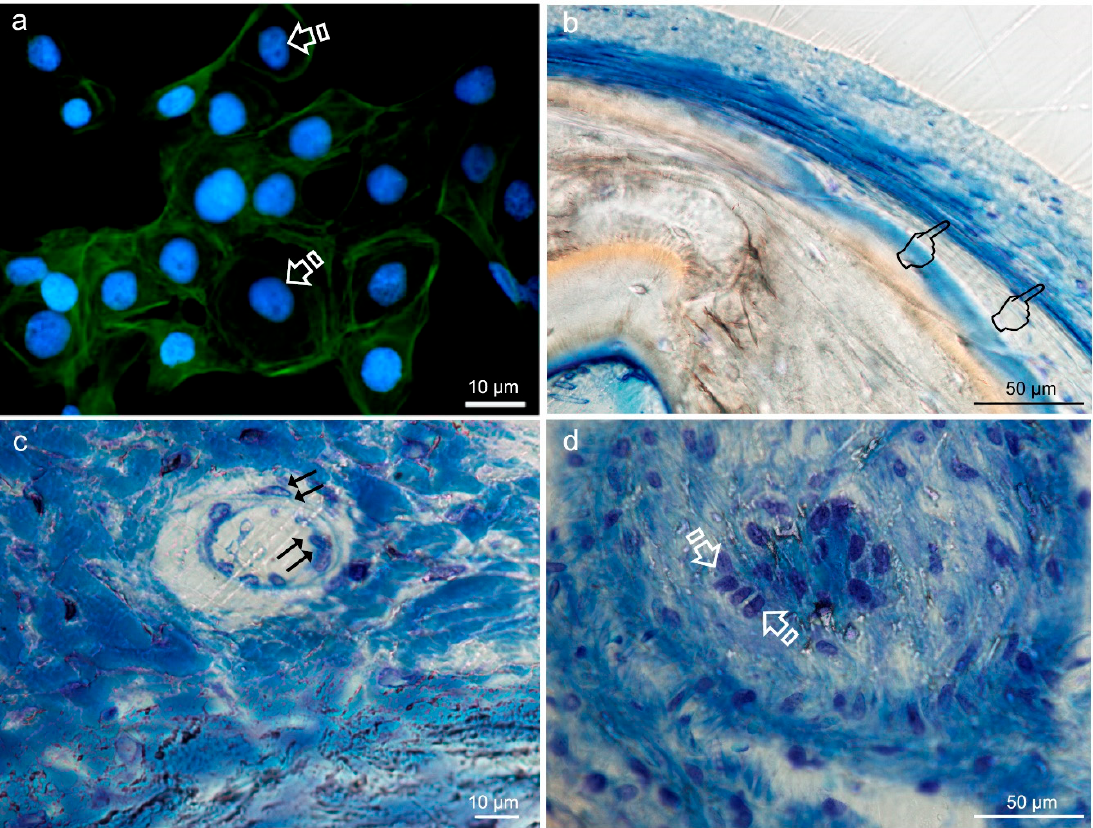
Figure 8. Typical round-shaped images of the keratinocytes cytoskeleton (arrows) obtained by immunofluorescence, from Niculi ţ e et al. [26]. Copyright MDPI, 2018 ( a ). Bone histology obtained after using silica-loaded carboxilated doxycycline-doped membranes ( b , c ) and blank control (no membrane) ( d ), by coloration with toluidine blue to visualize the elongated fibroblasts (pointers in ( b )), fusiform endothelial cells of blood vessels (double arrows in c ) and cuboid osteoblastic cells (faced arrows in ( d )), at 6 weeks of healing time in animal experimentation (Toledano et al. /